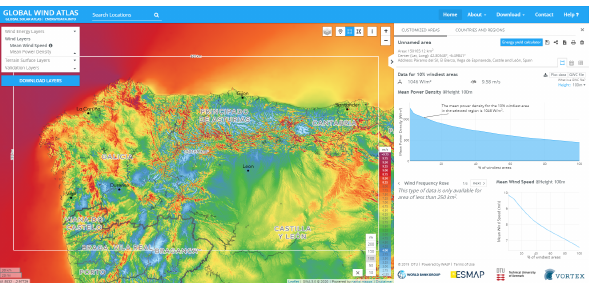
Figure 15. Global Wind Atlas: Download data for a height of 100 m, drawing a rectangle. Data source: